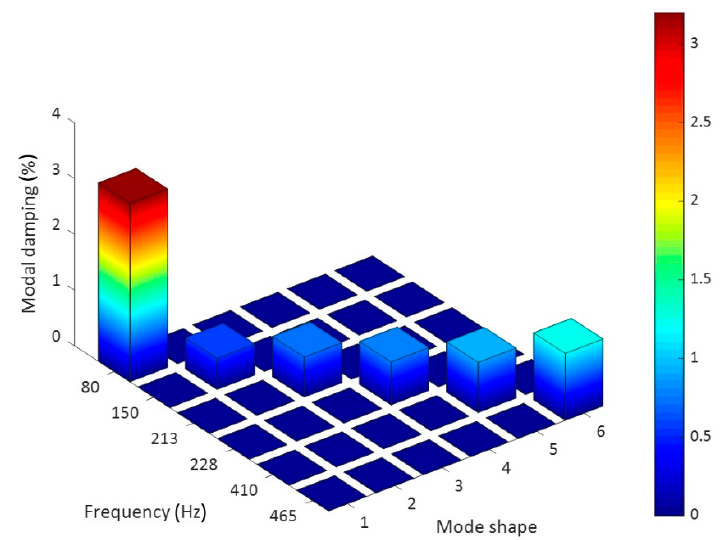
Figure 17. Modal structural damping for the six elastic mode shapes.